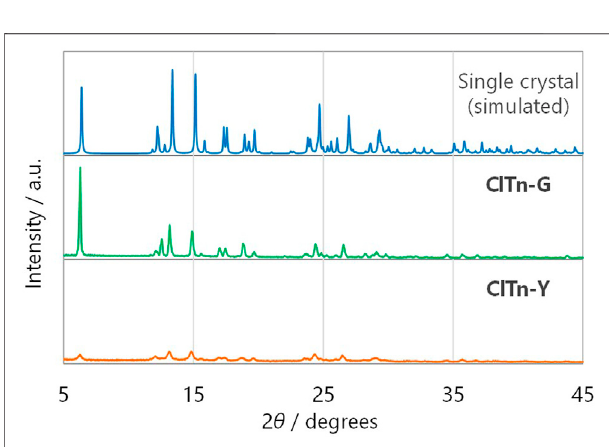
FIGURE 6 | Powder X-ray diffraction patterns of (from top to bottom ) single-crystals of ClTn (simulated), ClTn-G , and ClTn-Y